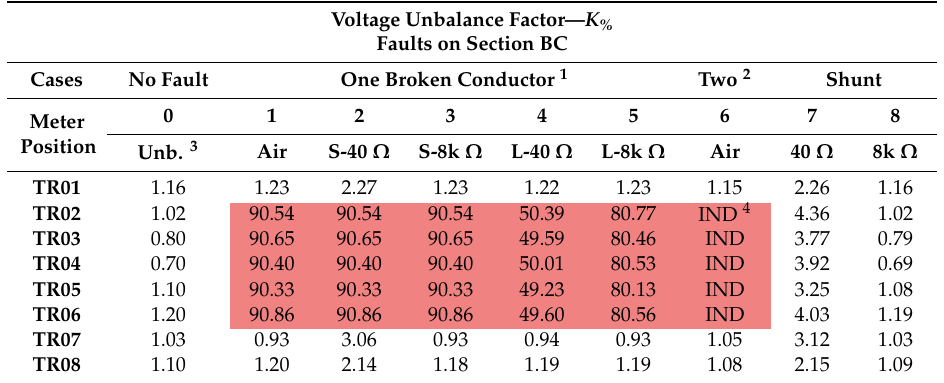
Table 8. Faults on section BC—voltage unbalance (results of K % for normal and fault condition).